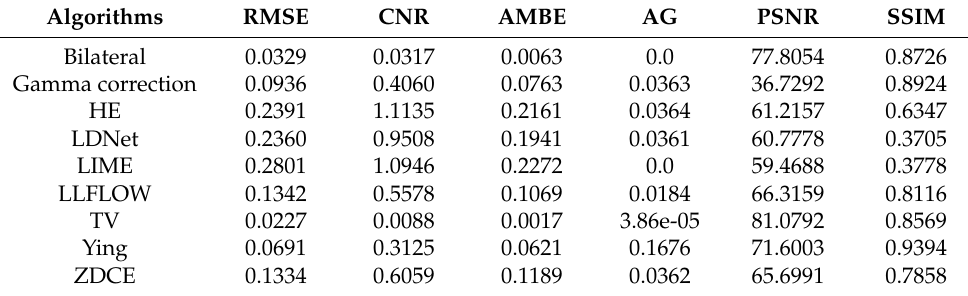
Table 3. Quality metrics for image enhancement